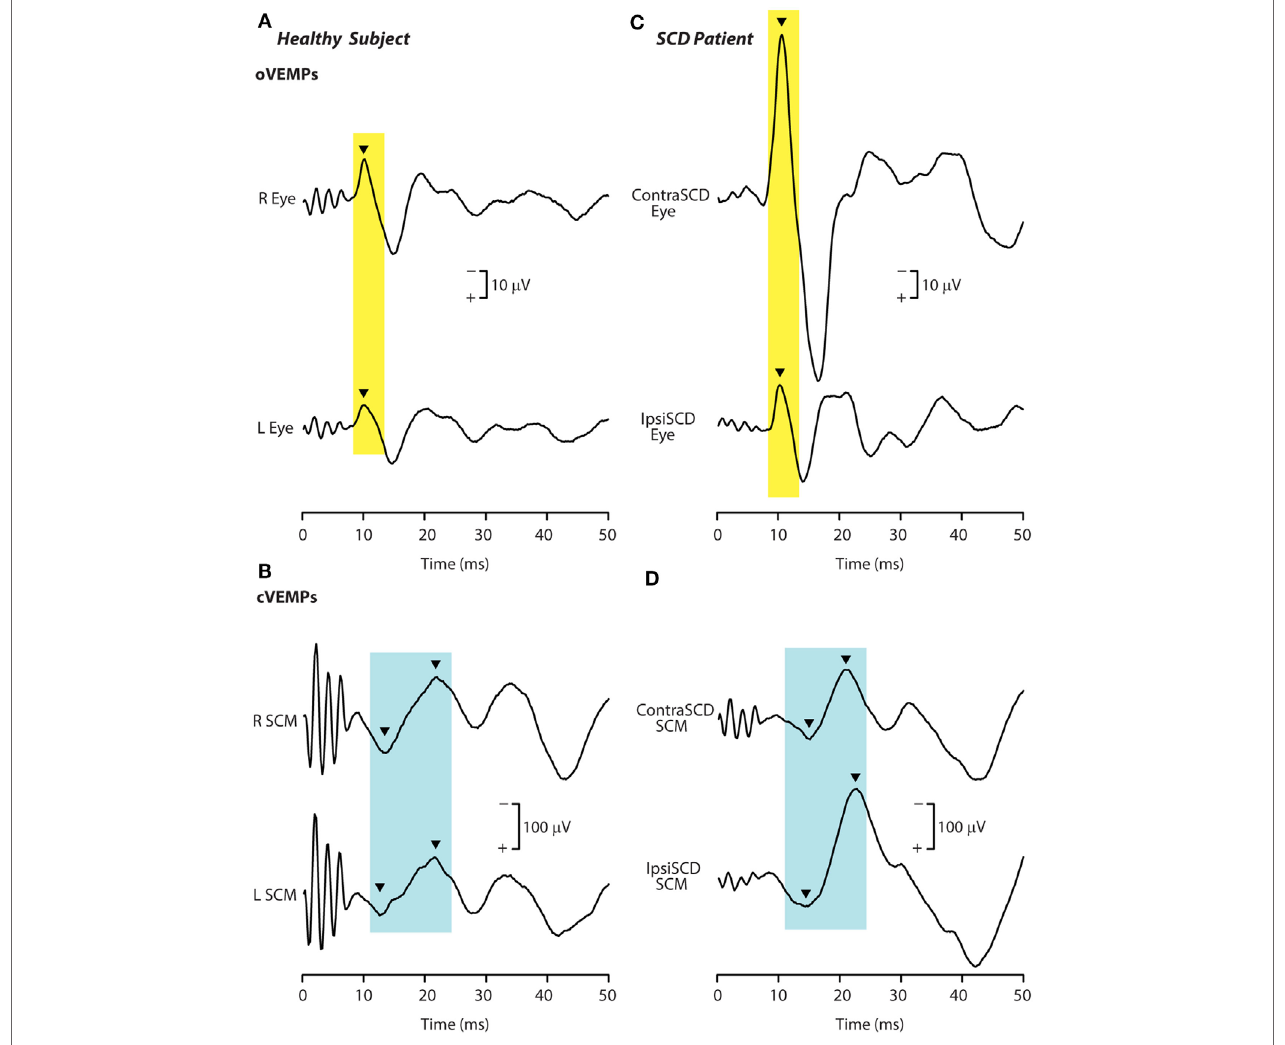
FigURe 10 | Recordings of ocular vestibular-evoked myogenic potentials (oVEMPs) (A,C) and cervical vestibular-evoked myogenic potentials (cVEMPs) (B,D) to 500 Hz bone-conducted vibration (BCV) from a healthy subject (A,B) and a patient with semicircular canal dehiscence (SCD) (C,D) . In each record, the stimulus onset occurred at time 0. In the healthy subject, BCV at the midline of forehead at the hairline (Fz) causes symmetric oVEMP beneath both eyes, with approximately equal amplitude oVEMP n10 components (arrowheads). By contrast, the same Fz stimulus causes an asymmetric n10 component of the oVEMP response in the patient: the oVEMP n10 recorded from beneath the contralesional eye is much larger than the oVEMP n10 recorded from beneath the ipsilesional eye, and is also much larger than seen in the healthy subject. In response to BCV at Fz, both subjects show clear cVEMP p13–n23 [arrowheads in (B,D) ]. The response in the ipsilesional sternocleidomastoid muscle (SCM) in the patient is larger than in the patient’s contralesional SCM, but the asymmetry is not as great as in the same patient’s oVEMP traces. The cVEMP responses of the normal subject are more symmetrical than in the SCD patient. Reprinted by permission from Wolters Kluwer Health, Inc.: Manzari et al. (94), ©